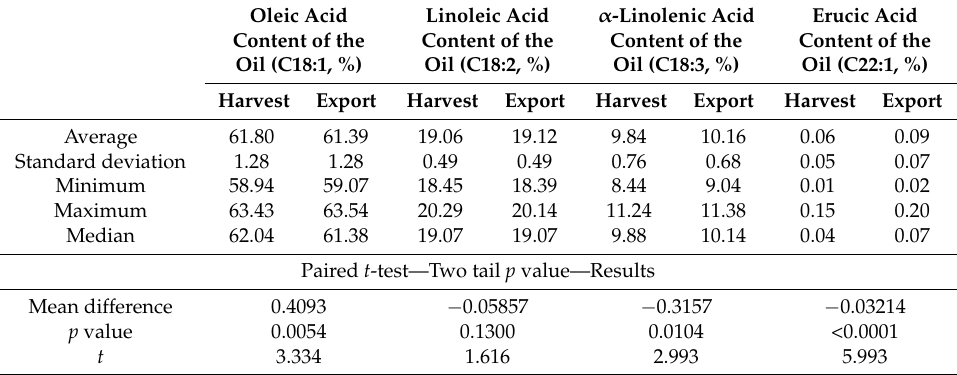
Paired t -test—Two tail p value—Results